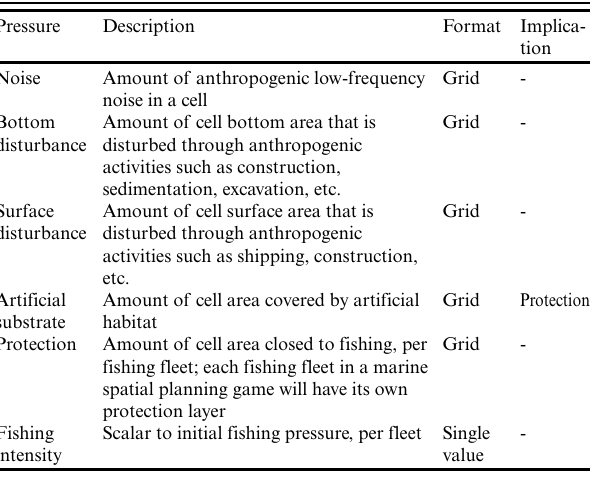
Table 1. Pressures that reflect environmental disturbance caused by marine spatial planning activities. Each layer expresses the amount of the cell area covered by a pressure, per cell, across the game area.